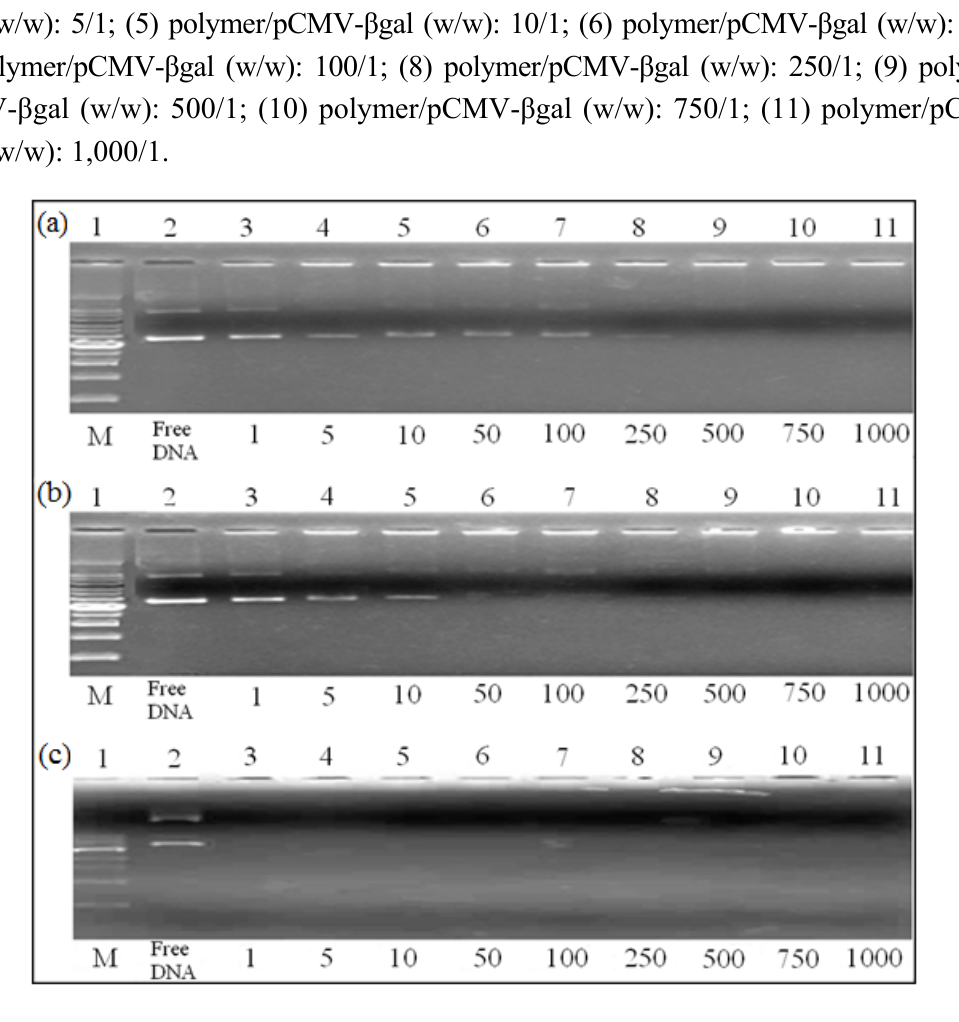
Figure 7. DNA gel retardation assay of EPAE ( a ) EPAE-FA12k; ( b ) and